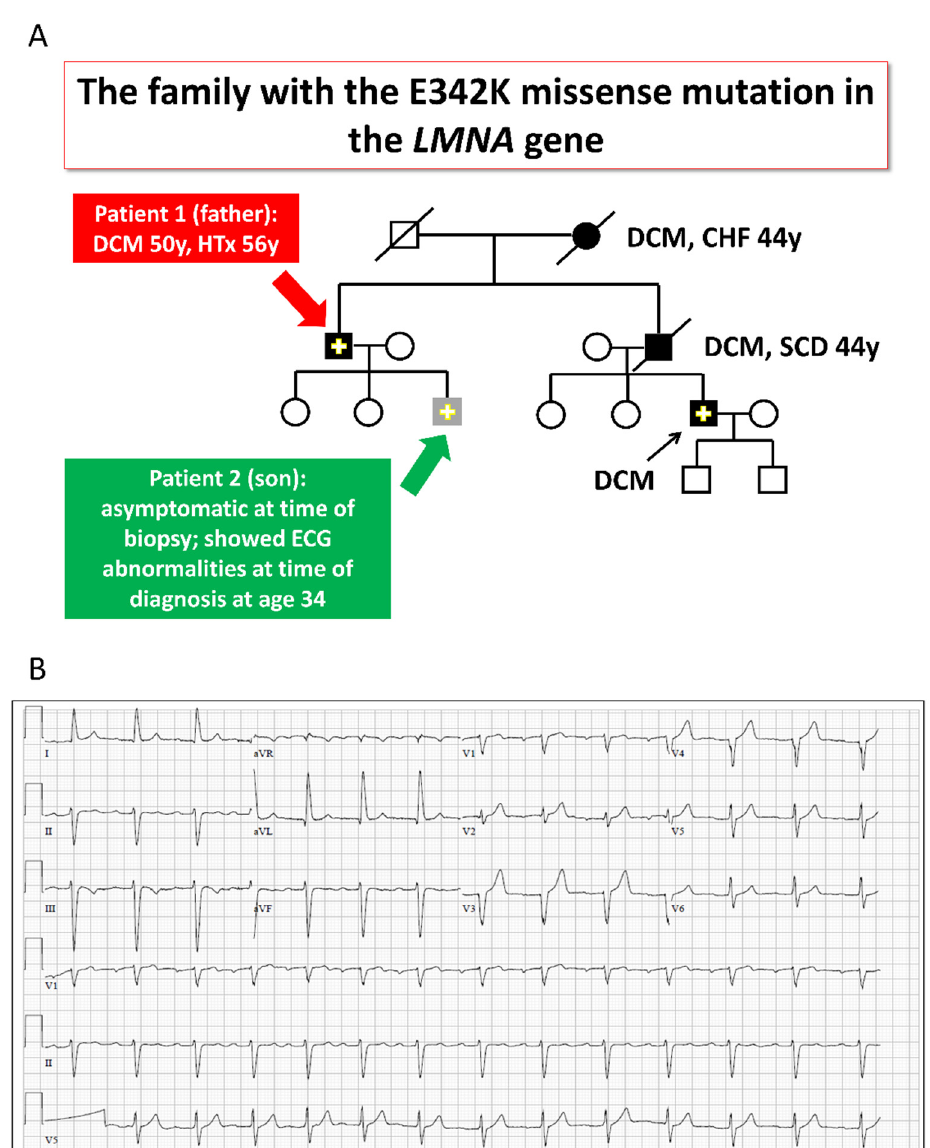
Figure 1. The LMNA -mutated patients. ( A ) Pedigree of the family with the LMNA gene mutation. Solid symbols: affected individuals; Solid symbols with a “+”: an affected individual with a proven mutation; Open symbols: clinically unaffected; Crossed symbol: deceased. Red arrow: a 63-year-old (at time of biopsy) DCM male patient, who underwent heart transplantation at age 56 for his severe heart failure (ejection fraction of 19%). His brother died at the age of 44 from the same disease, while awaiting heart transplantation. Green arrow: The 35-year-old son (at time of biopsy) of the 63-year-old patient was asymptomatic, but showed ECG abnormalities at the time of diagnosis at age 34. Biopsies were obtained from both the father and son. ( B ) Twelve-lead ECG of the son at age 34 demonstrating first-degree AV block and left anterior fascicular